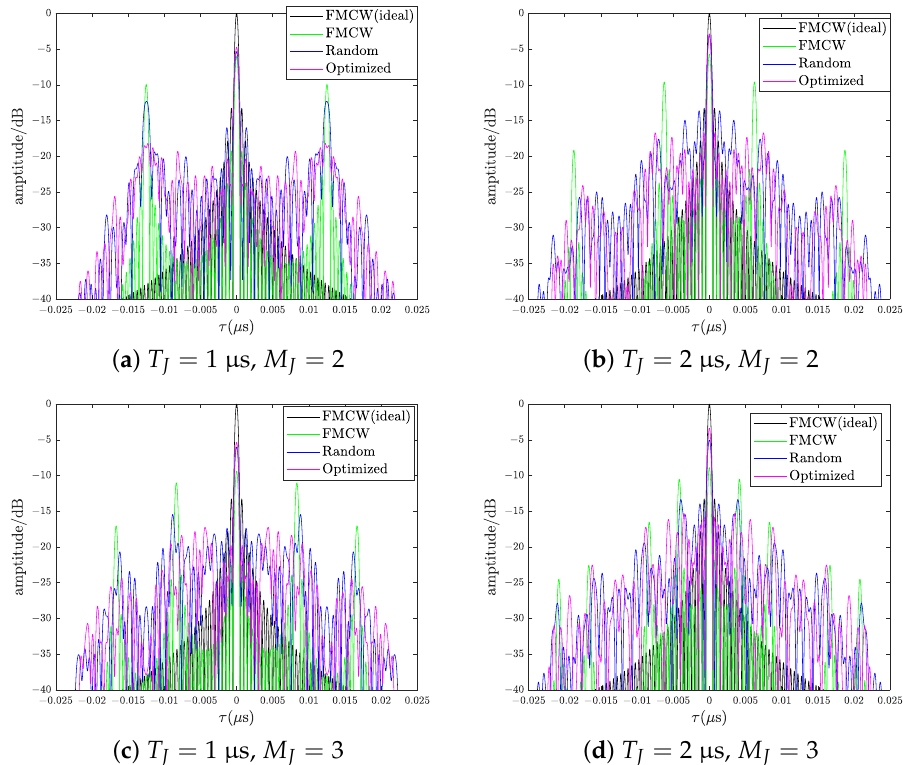
Figure 10. Range profile comparison of different waveforms under different jamming